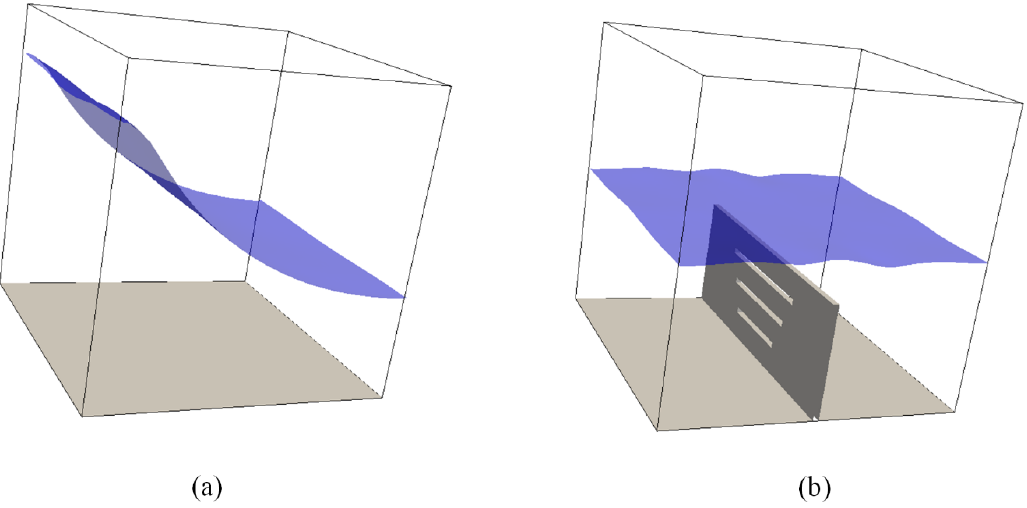
Figure 8. Comparison of three-dimensional views of free-surface at t = 9.5 s. ( a ) Conventional tank and ( b ) slot-baffle design (a supplementary video file is available for the animation of the liquid sloshing).